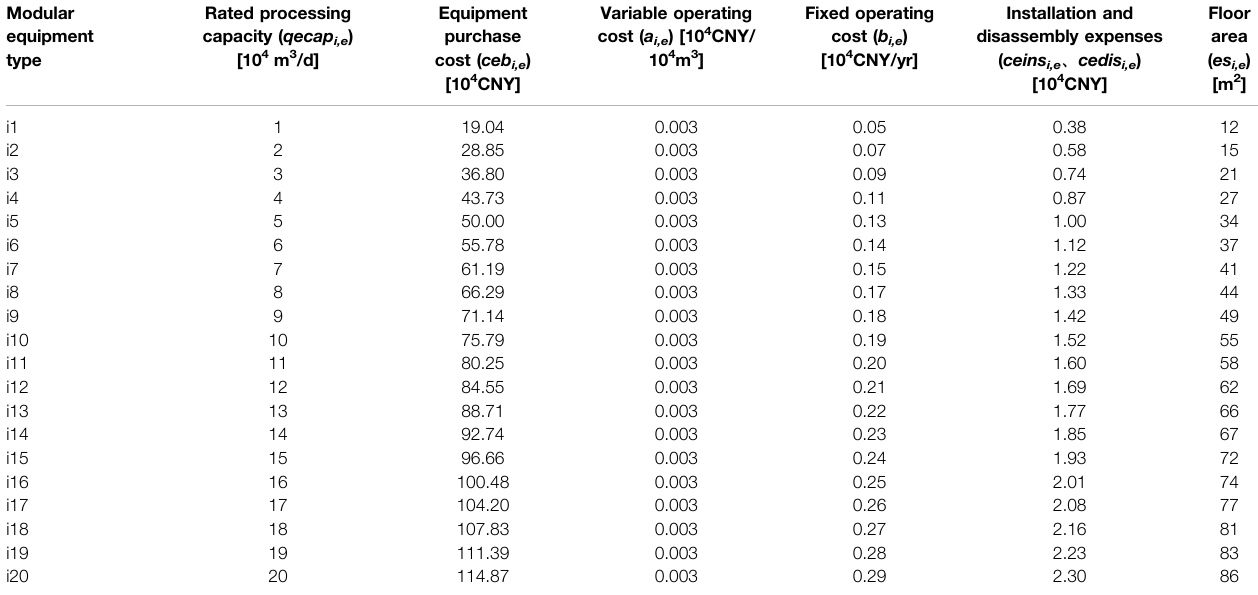
TABLE 1 | Equipment parameters.